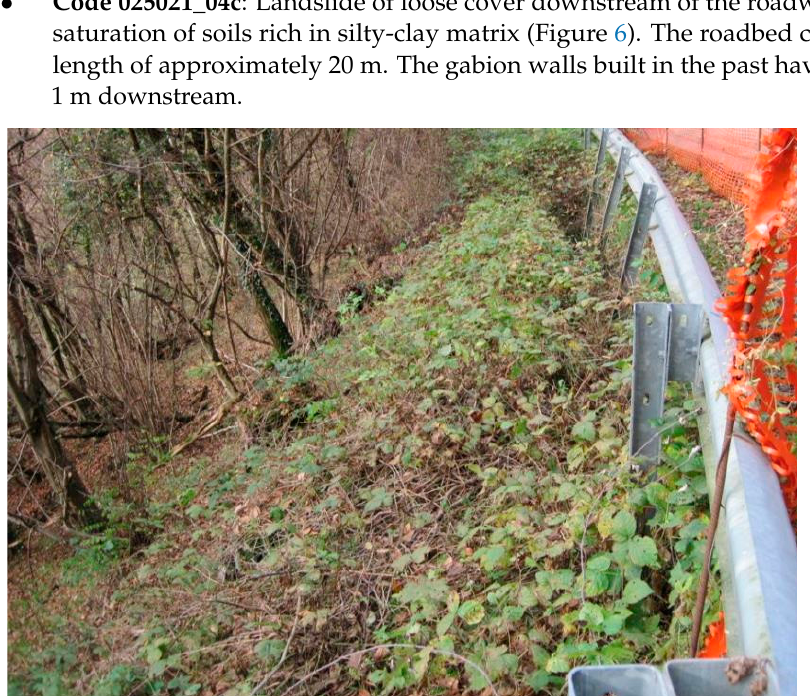
Figure 6. Landslide photograph code 025021_04c.